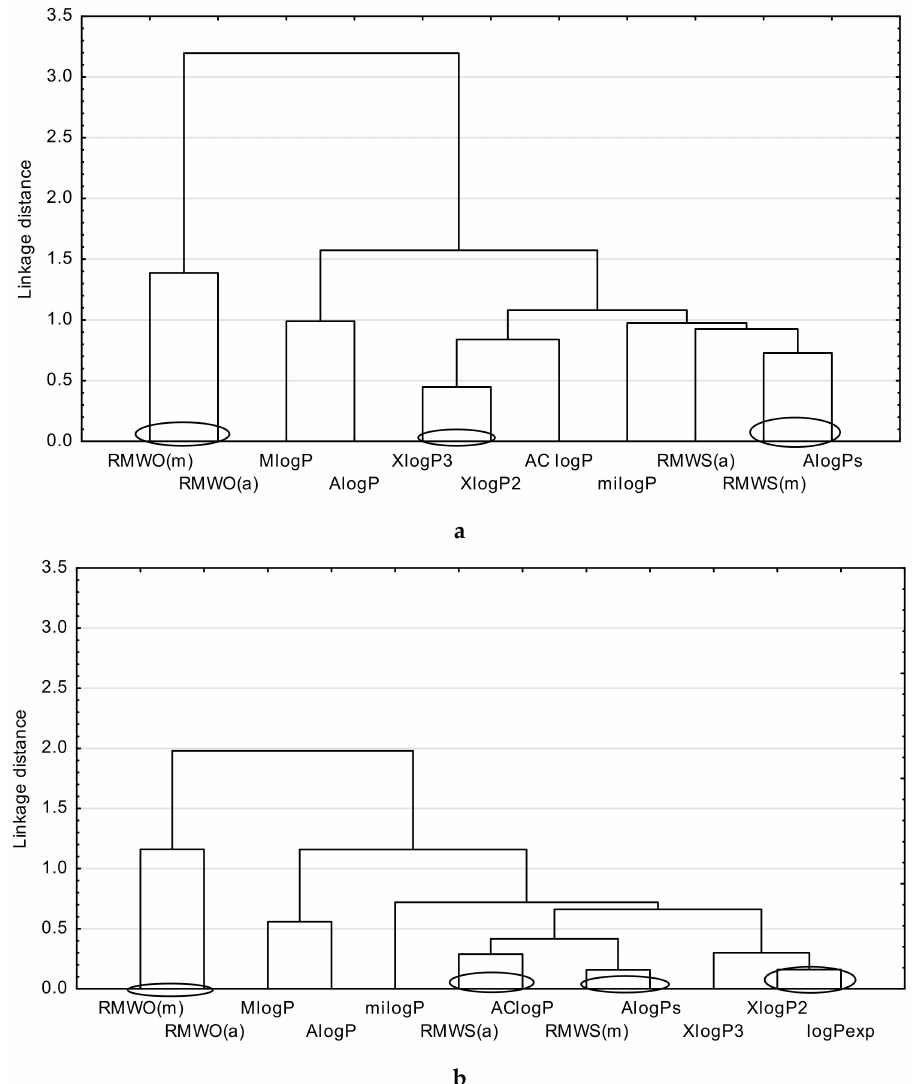
Figure 2. A similarity analysis for antihypertensive drugs, including: ( a ) comparison of the chromatographic and theoretical parameters of lipophilicity. ( b ) comparison of the chromatographic, theoretical and experimental parameters of